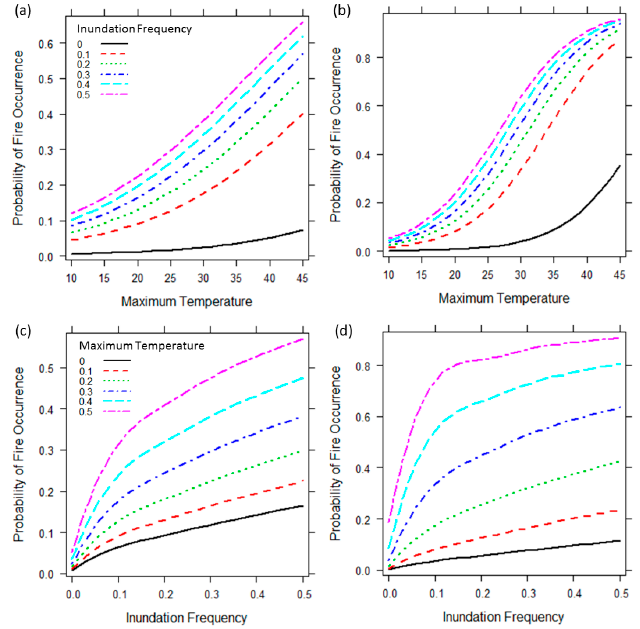
Figure 4. Probabilities of ( a,c ) human-caused and ( b,d ) natural fire occurrence as a function of Maximum Temperature and Inundation Frequency.